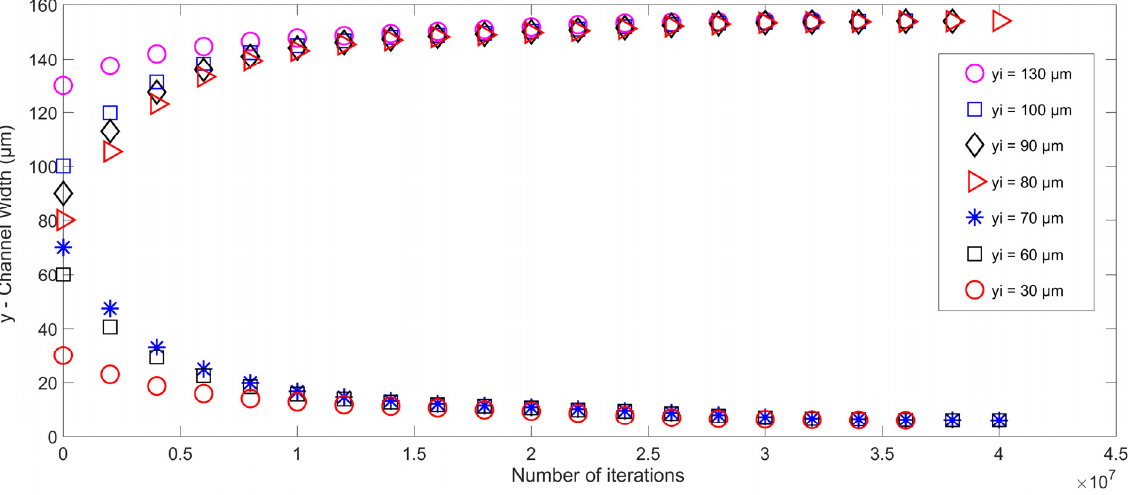
Figure 10. The trajectory of microparticles subjected to acoustic radiation force in the microchannel in the presence of two pressure nodes (at the upper and lower sides) of the microchannel.